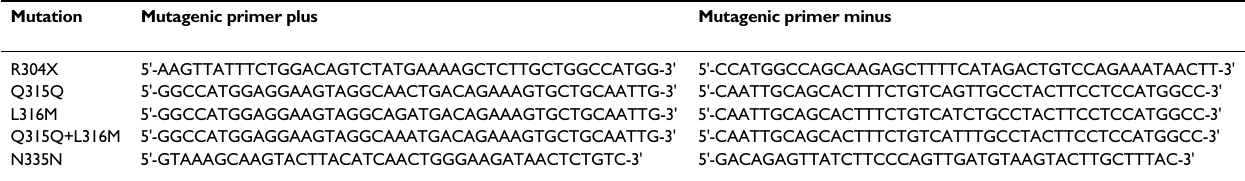
Table 1: Sequence primers used for in vitro mutagenesis.